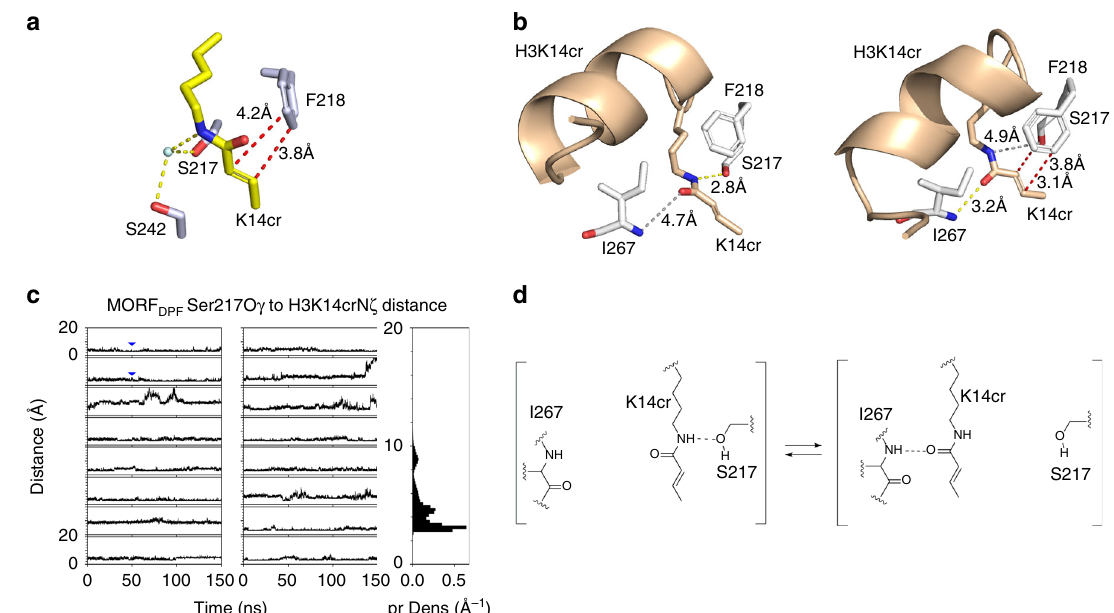
Fig. 3 The ping-pong-like acyllysine-binding mechanism. a A zoom-in view of the H3K14cr-binding pocket of MORF DPF . Yellow dashed lines represent water (cyan)-mediated hydrogen bonds. Red dashed lines represent short distances indicative of the π − π interaction. b A close view of the H3K14cr- binding site of the MD generated complex. Yellow and red dashed lines represent hydrogen bonds and short distances indicative of the π − π interaction, respectively. Gray lines show long distances between the indicated residues. c (left two columns) Time-course of the distance between Ser217O γ of MORF DPF and K14crN ζ of H3. Blue triangles correspond to the timing of snapshots shown in b . All plots share the same ordinate (between 0 and 20 Å). (Right column) Distribution of the distance between two atoms. Abscissa and ordinate represent the probability density (pr Dens) and the distance between Ser217O γ of MORF DPF and K14crN ζ of H3. d A schematic showing shuf fl ing of K14cr between two conformations in the MORF DPF